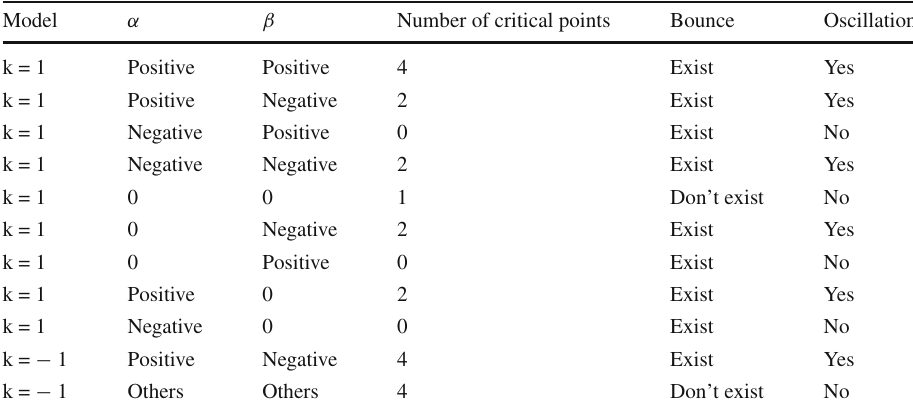
points and existing bouncing-oscillating solutions for positive, negative and zero values of (α,β) pre-factors of entropy-corrected Friedmann equations describing the k = 1 and k = − 1 curved